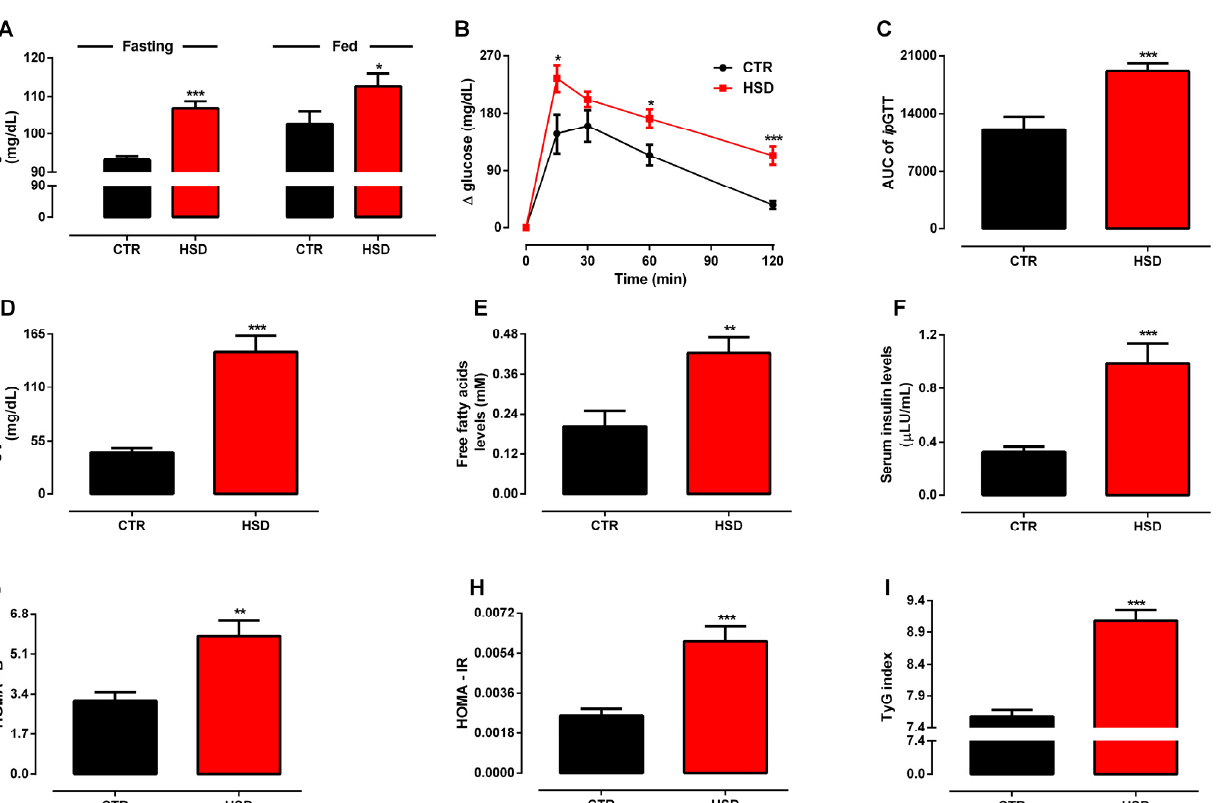
6 of 16 Figure 1. Morphometric parameters. ( A ) Body weight (BW, g) and AUC, ( B ) Lee index (g 1/3 · cm − 1 × 1000), ( C ) energy intake (Kcal/100g/day) and AUC, ( D ) relative weight (g/100g BW) of retroperitoneal fat, periepididymal fat, mesenteric fat, ( E ) skeletal muscles, ( F ) liver, and ( G ) total fat accumulation in the liver (g/liver weight (g)), assessed in rats fed a standard chow (CTR, n = 7)